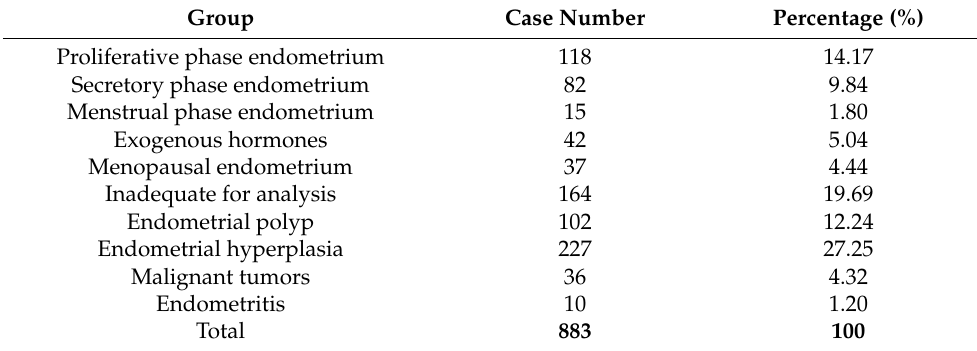
Table 6. Histopathological findings of samples extracted by scraping